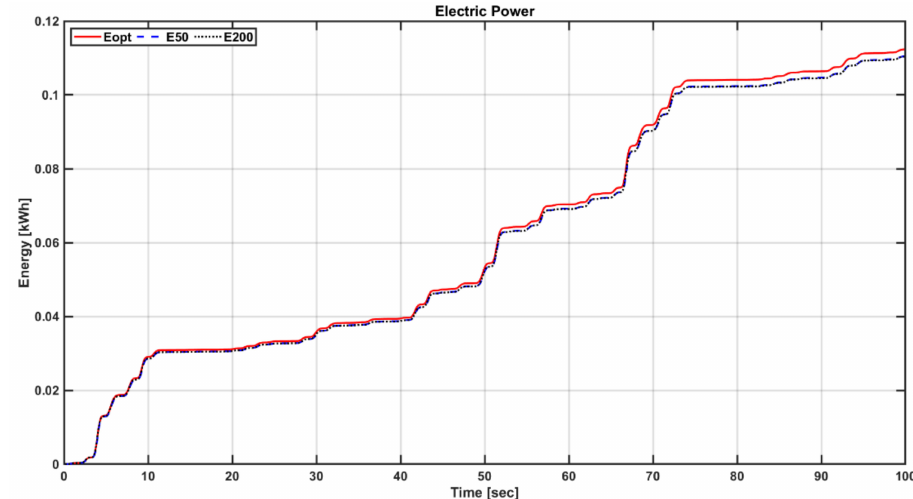
Figure 27. Output energy results of the PTO system in integrated simulation according to the torque factor of load control under irregular wave ( v t = 0~42 m / s and Tp = 4.75 s) input